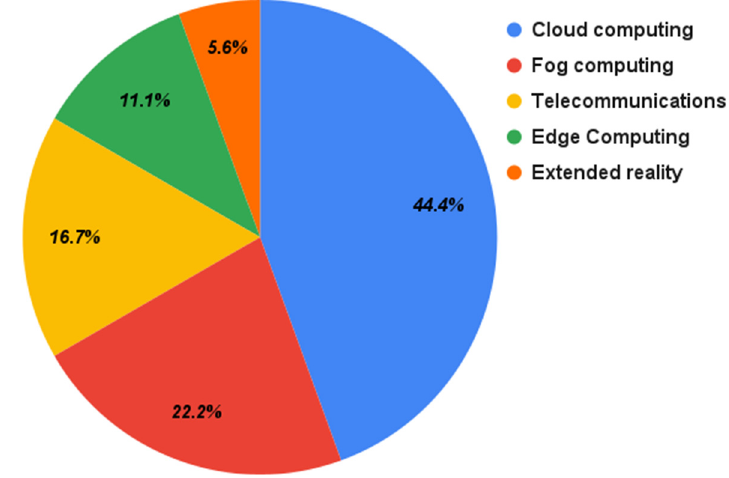
Figure 6. Adopted technologies in the integration.